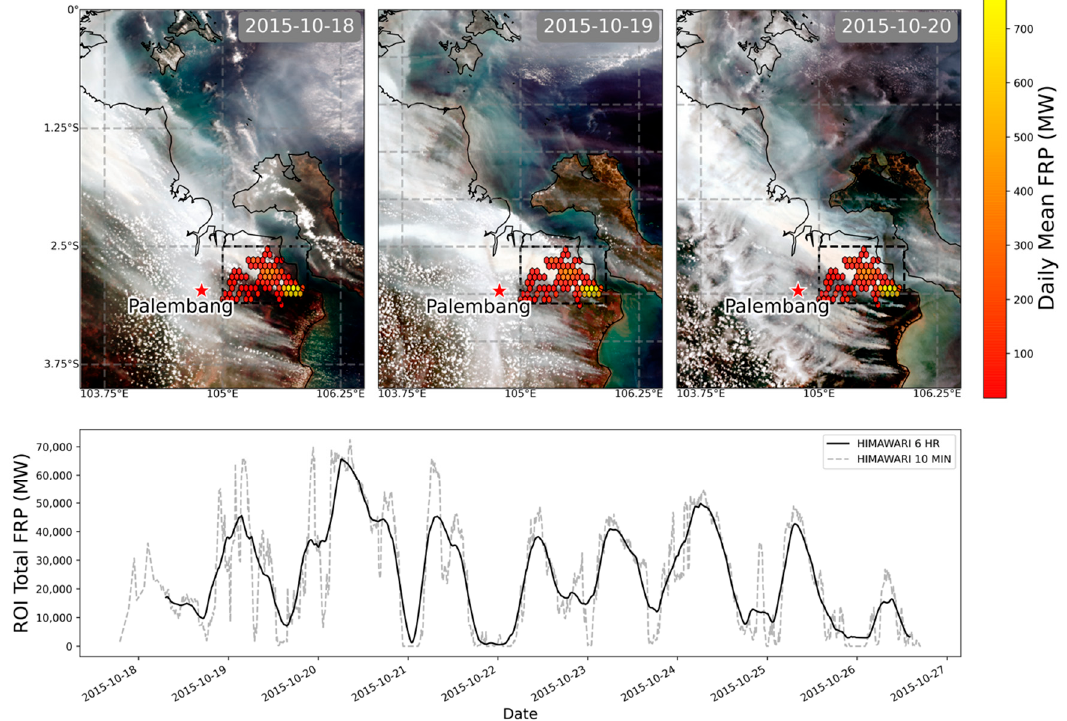
Figure 7. Data of the highly radiant Sumatran peatland fire associated with Plume 12 of Figure 2, and confirmed as showing flaming as well as smouldering activity in Figure 5. The upper plot shows the smoke plume and the spatial distribution of mean Himawari-8 derived FRP for three days of the fire. The lower plot shows the nine-day time series (each tick represents a 24-h period) of total Himawari-derived FRP for the fire (contained in the black bounding box marked in the images), with the dashed line showing the original 10-min resolution data and the solid line a 6-h sliding window. The data from this fire used in the matchup process to derive C e (Figures 2 and 3) came from the 20 October 2015 record (Table 1).